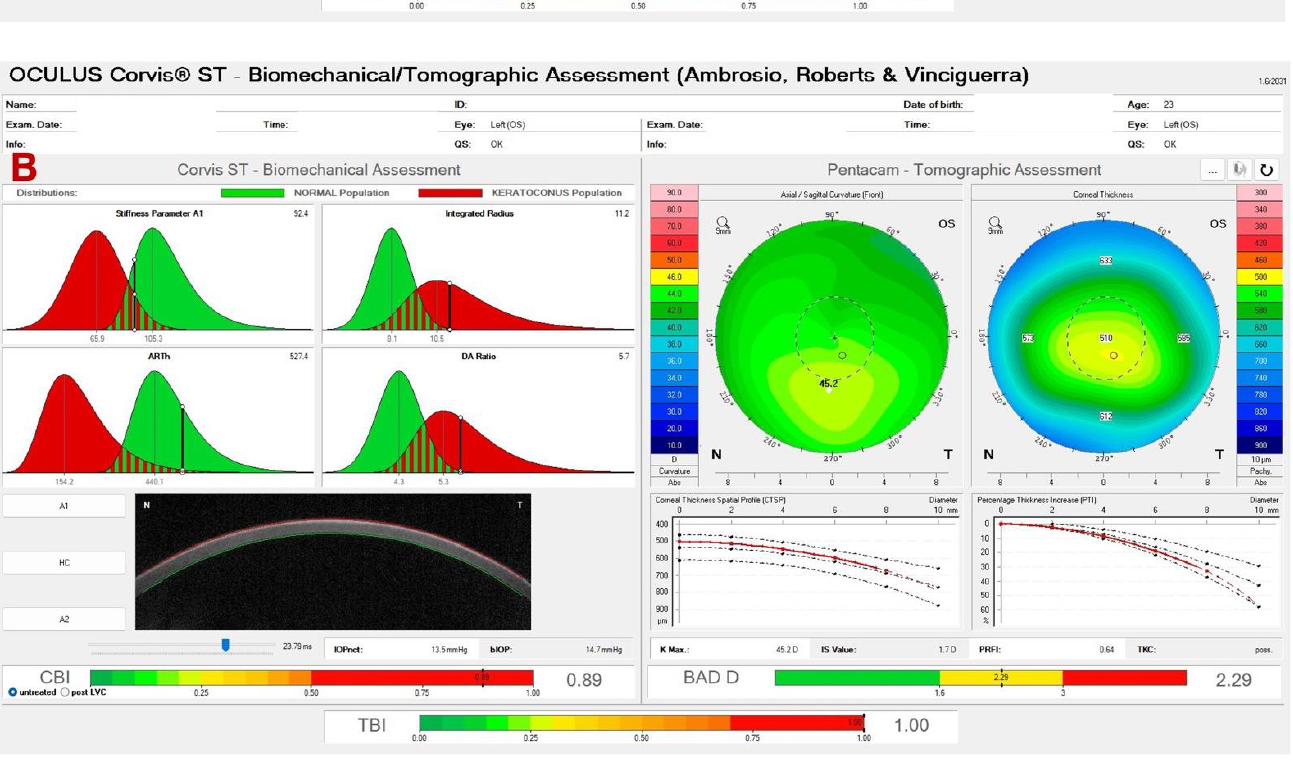
Figure 3. Corvis-ST Tomographic Biomechanical Display (ARV) from OD ( A ) showing a low SPA-1 (78.1). OS ( B ) which confirmed the diagnosis of VAE was by BAD-D of 2.29, CBI of 0.89, and the TBI of 1.0.